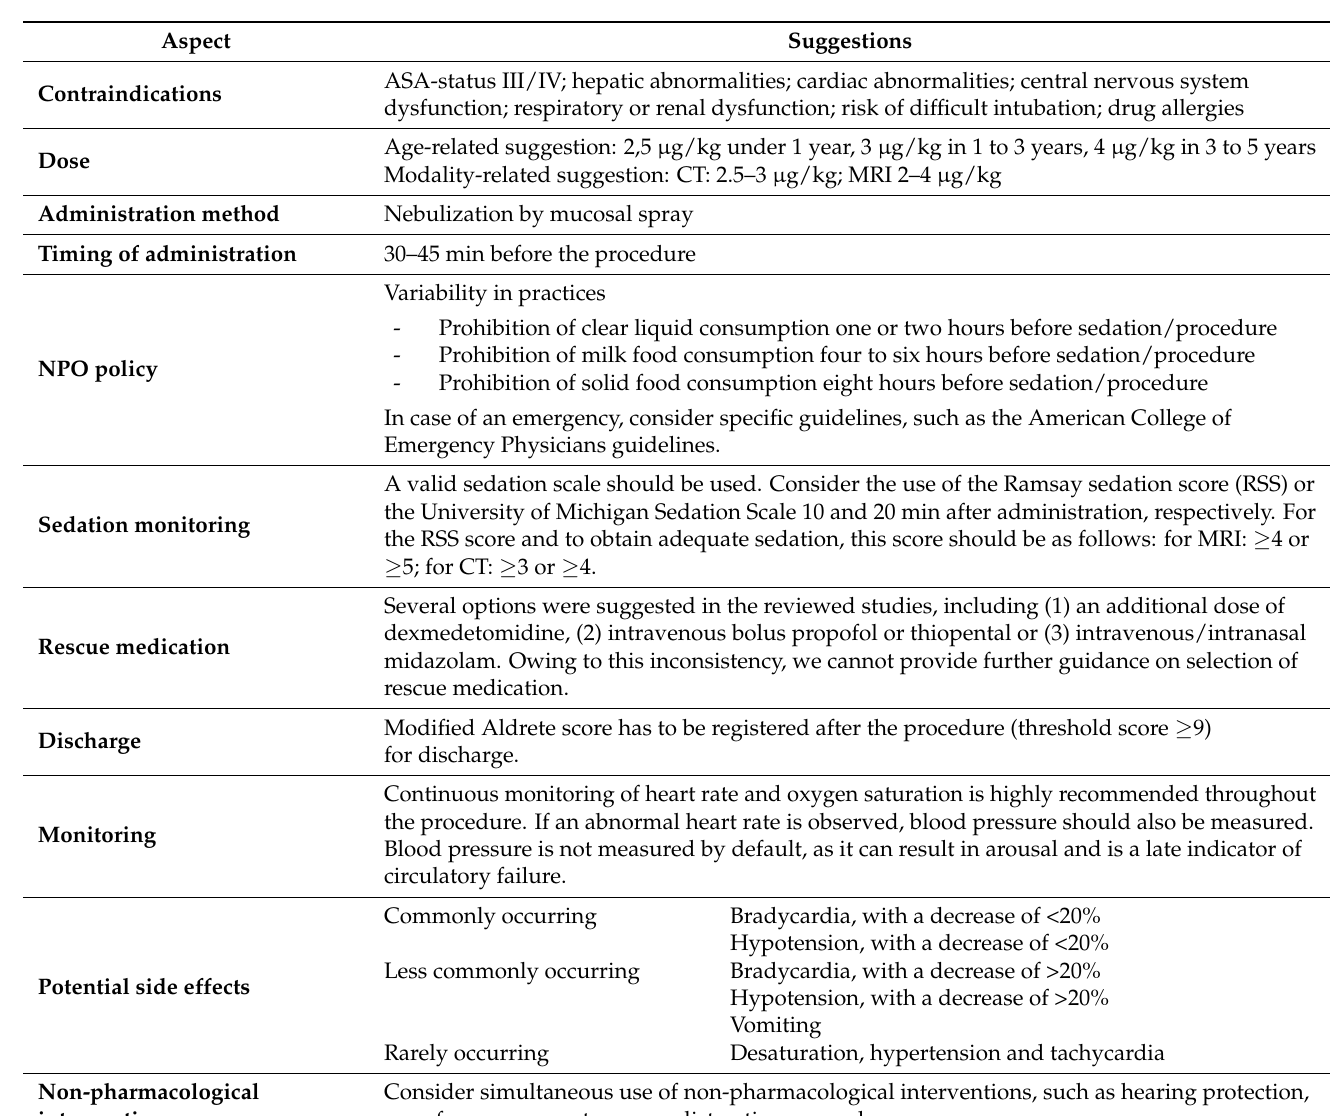
Table 1. A suggested roadmap with respect to aspects to consider in the development of an evidence- guided clinical protocol on intranasal dexmedetomidine use in young